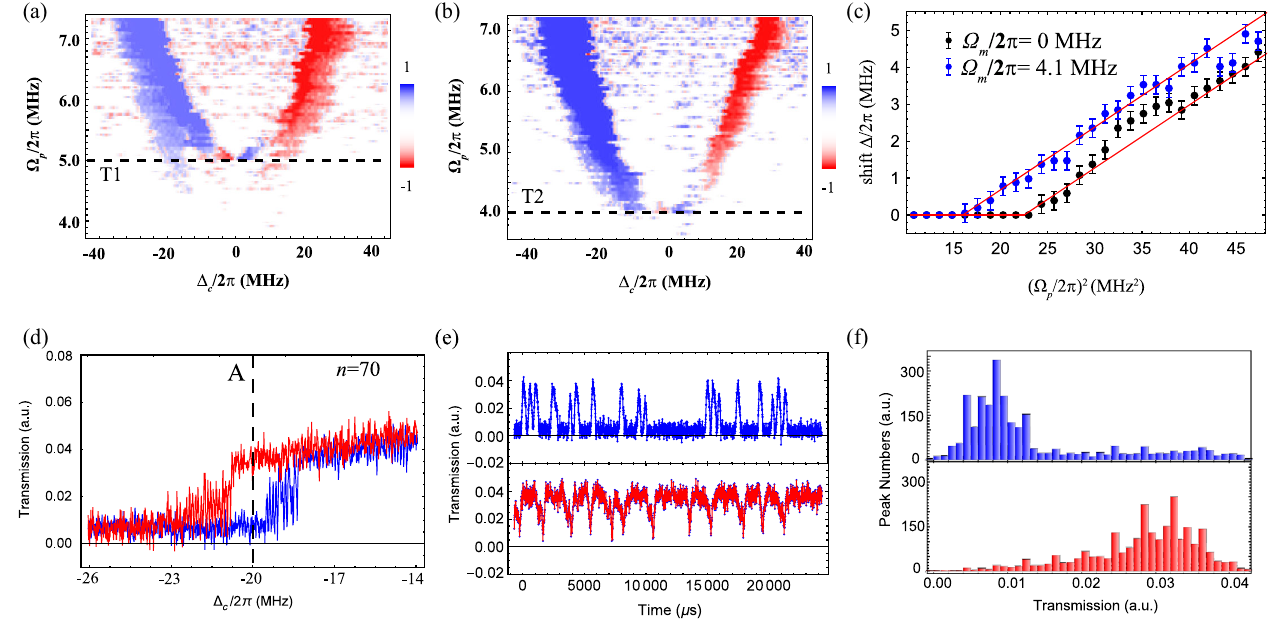
FIG. 5. Manipulating the phase diagram and optical switching. (a,b) Phase diagrams (at n ¼ 47 ) without (a) and with (b) the switching field applied (colors are as in Fig. 4). While the structure of the diagram remains unaffected, the transition occurs at a reduced threshold Ω = 2 π Þ 2 without (black) and with the switching with the switching field applied (T2 vs T1). (c) Interaction-induced shift Δ (cid:3) vs ð Ω p; ð c Þ p is scanned with and without the switching field applied (here, n ¼ 70 ). (e) Transmission over time at field (blue). (d) Transmission as Δ c = 2 π ¼ − 20 MHz [line A in panel (d)] without (top, blue) and with the switching field (bottom, red). (f) Histogram constant detuning Δ c of transmitted intensity levels without (top, blue) and with the switching field (bottom,